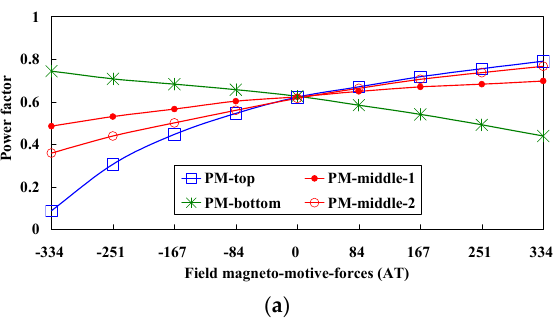
( b ) Employing NdFeB.